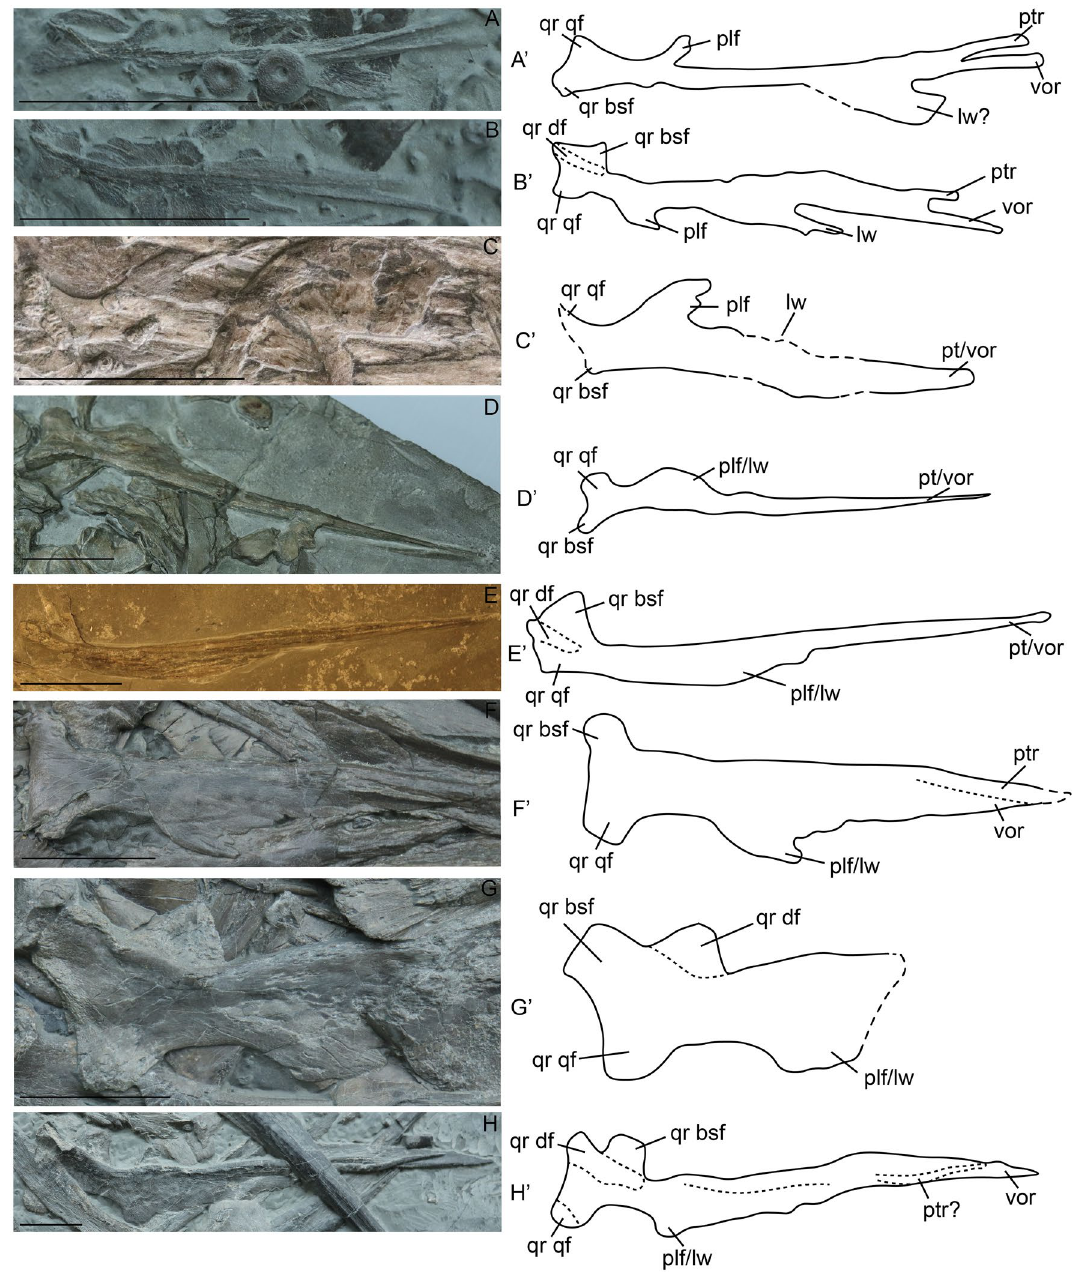
Figure 6. Pterygoids of selected specimens of Stenopterygius in ventral ( A , C – D , F – G ) and dorsal ( B , E , H ) view. Interpretative drawings denoted by an apostrophe with their corresponding letter. ( A ) stage 3 embryo S. quadriscissus SMNS 80234; ( B ) stage 3 embryo S. quadriscissus SMNS 80234; ( C ) stage 4 embryo S. quadriscissus SMNS 54062; ( D ) postnatal 1 S. quadriscissus SMNS 51139; ( E ) postnatal ?2 Stenopterygius quadriscissus 50183; ( F ) postnatal 2 S. quadriscissus SMNS 81958; ( G ) sexually mature S. quadriscissus SMNS 81961; ( H ) sexually mature S. quadriscissus SMNS 80234. lw lateral wing, plf palatine facet, ptr antimeric pterygoid ramus, qr bsf quadrate ramus, medial (basisphenoid) flange, qr df quadrate ramus dorsal flange, qr qf quadrate ramus quadrate flange, vor vomerine ramus. Scale bar ( A – H ) = 30 stages (Supplemental Fig. 9C,D). However, the symphyseal facets are less apparent in postnatal stage 1 and are absent in embryonic stage 3 (no splenials were preserved in medial view in stage 4 embryos). The relative length of the dorsal and ventral processes is consistent throughout ontogeny. Surangular. The surangular is clearly visible in embryonic stage 2 and is well ossified relative to braincase and skull roof elements in embryonic stage 3 (Fig. 1). The surangular is close to fully ossified perinatally and fully ossified in postnatal stage 1 (Fig. 7A,G). The surangular fossa is visible in embryonic stage 3, but the lateral